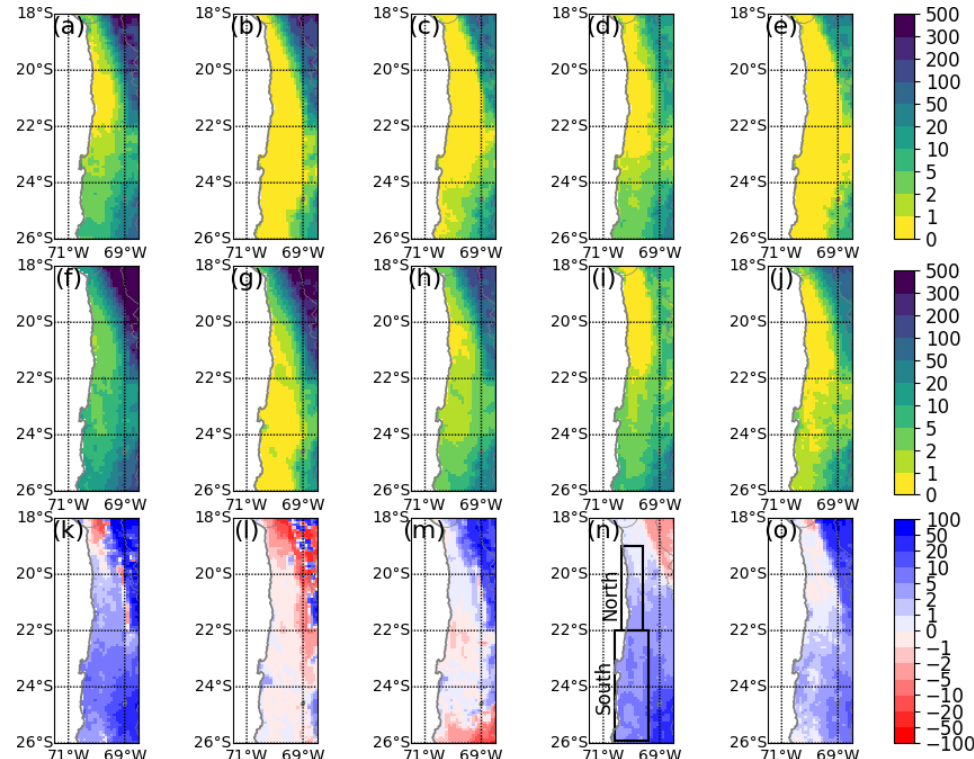
Figure 3. Present-day mean annual and seasonal rainfall as simulated by (a–e) WRF era and (f–j) WRF hist and (k–o) mid-Pliocene changes (WRF mP minus WRF hist ) in the mean annual and seasonal rainfall. Values for (a, f, k) the whole year, (b, g, l) DJF (December–January– February), (c, h, m) MAM (March–April–May), (d, i, n) JJA (June–July–August) and (f, j, o) SON (September–October–November). All results are shown for the simulations with 10km resolution, and values are given in millimetres per year and millimetres per season, respec- tively.